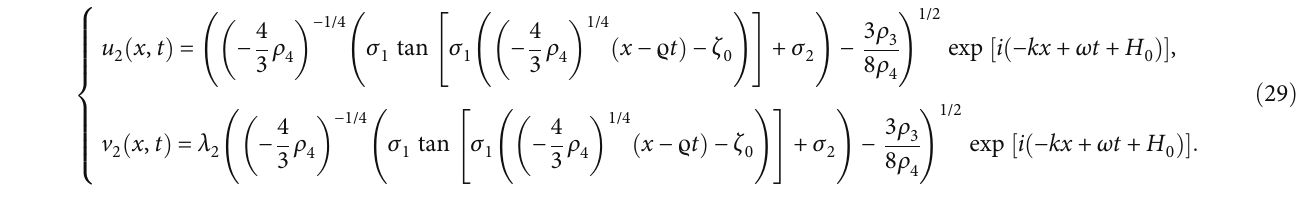
ð t , x Þ with a 3 = η = 2, θ 2 2